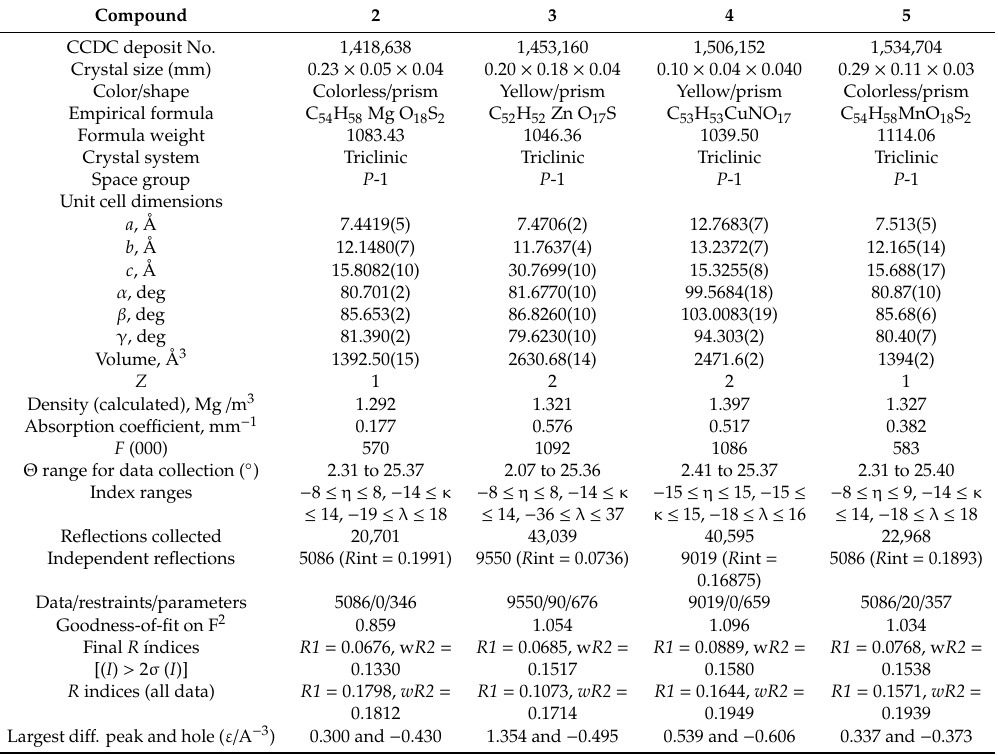
Table 6. Crystal Data, Collection Parameters and Refinements for compounds 2, 3, 4, and 5 . Compound CCDC deposit